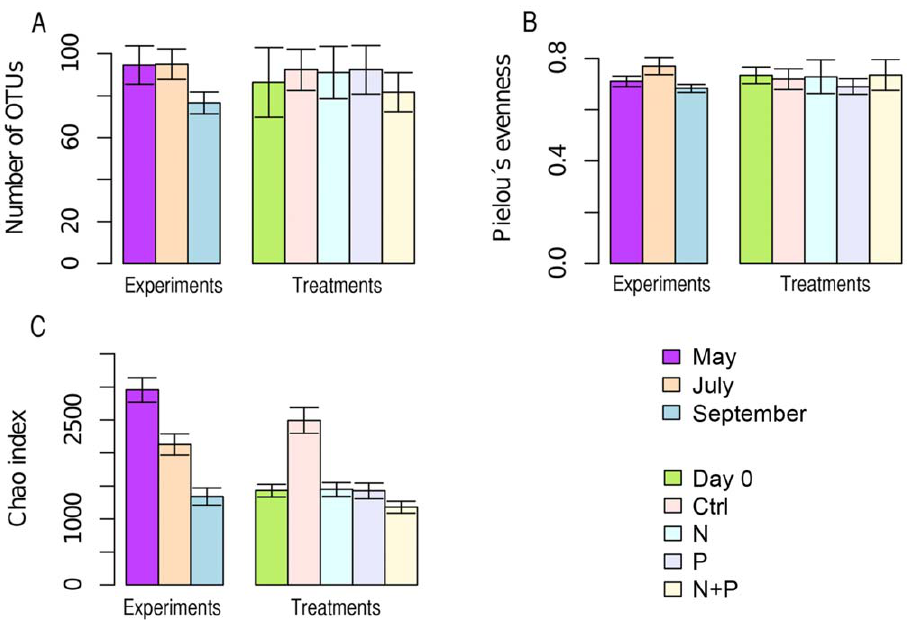
Figure 4. The mean number of OTUs (A), Pielou’s evenness index (B) and Chao richness estimate (C) in experiments and treatments. Error bars in (A) and (B) represent standard deviation and in (C) standard error.